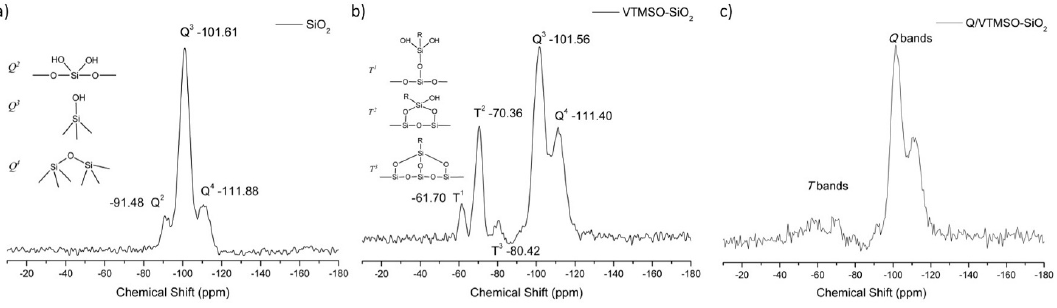
Figure 1. Solid-state 29 Si NMR spectra of SiO 2 ( a ), VTMSO-SiO 2 ( b ), and Q/VTMSO-SiO 2 ( c ). Inset: possible structure details with signal assignment.